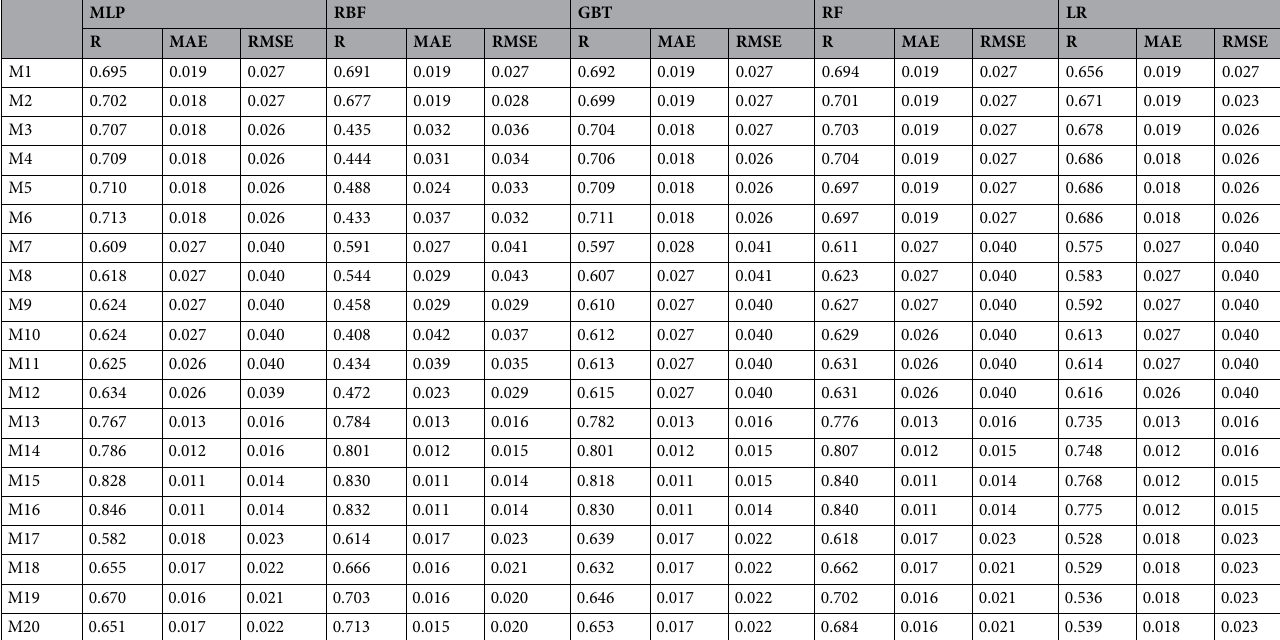
Table 3. Results of a performance evaluation using the developed ML techniques during testing